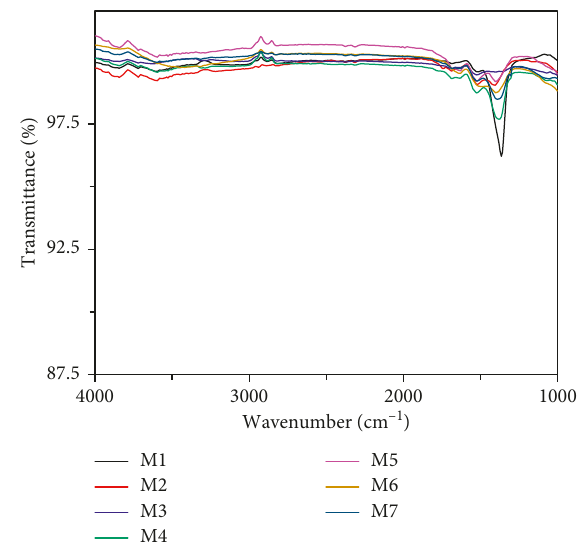
Figure 5: Infrared spectra of the photocatalysts Mg/Al-activated hydrotalcites at 500 ° C before photocatalytic degradation of 2,4,6-